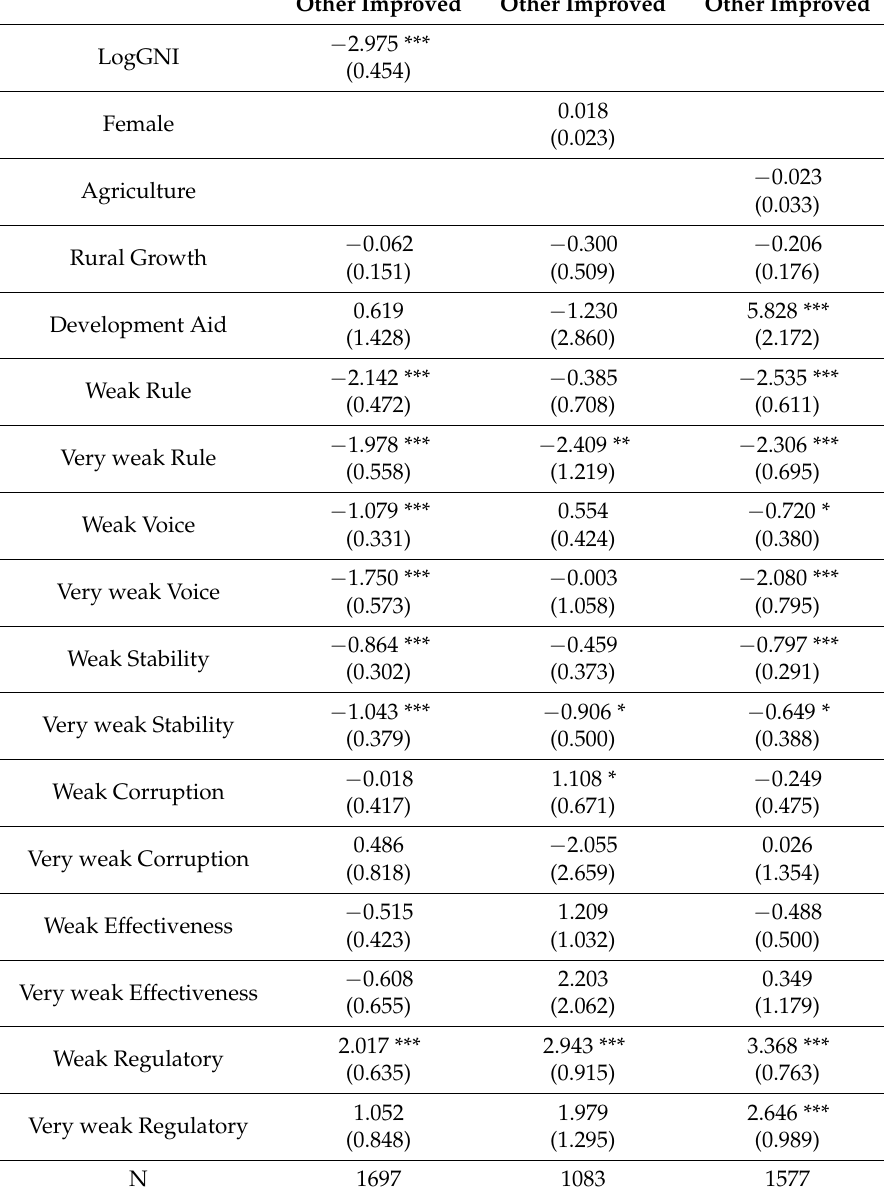
Table 4. Socioeconomic indicators. Global Data. Other improved